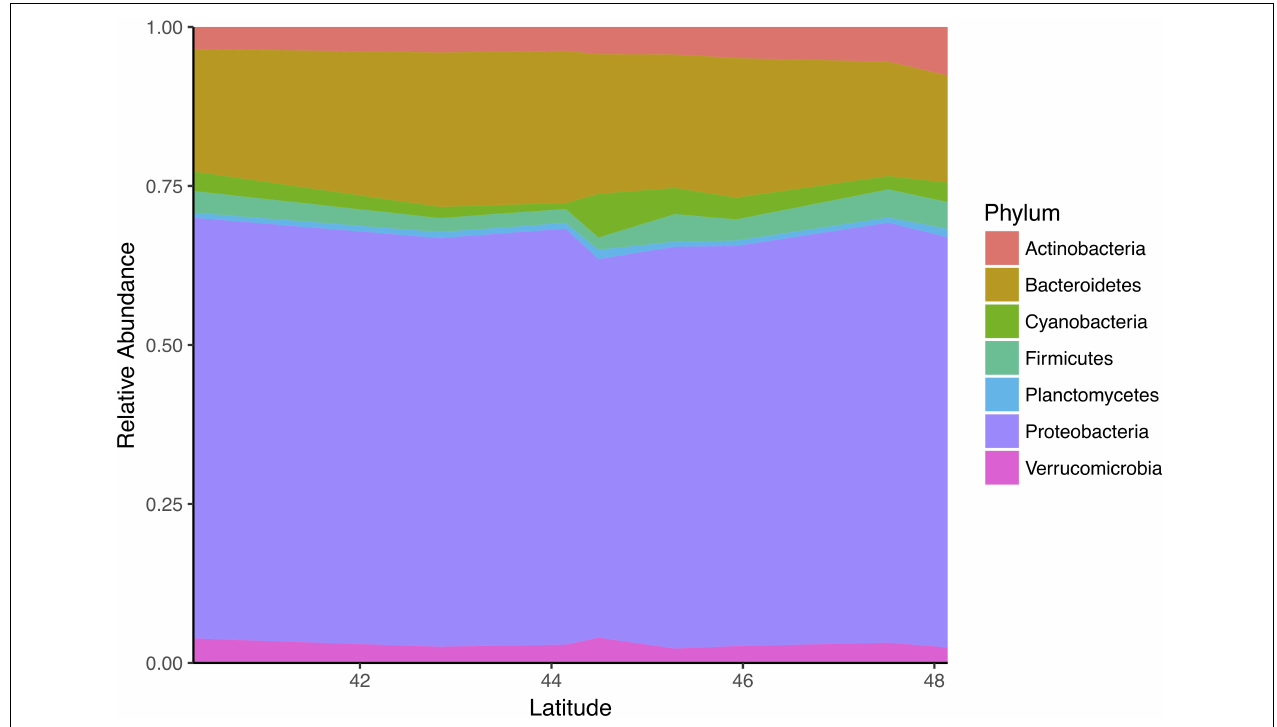
FIGURE 7 | Taxonomic composition of communities associated with A. elegantissima is dominated by Proteobacteria and Bacteroidetes across